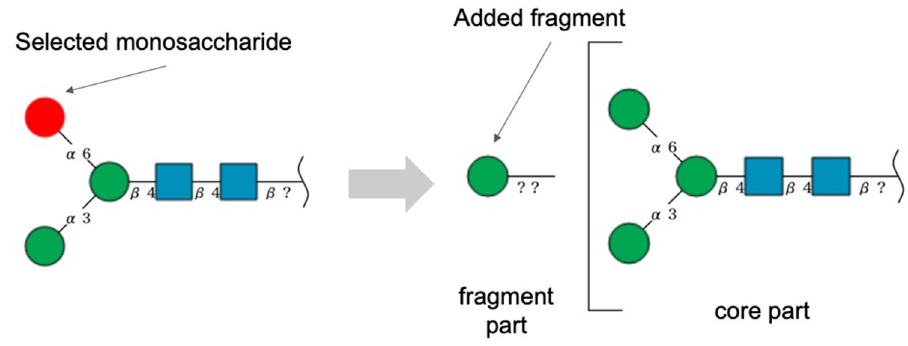
Figure 4. Addition of a monosaccharide as a fragment part using “Add Fragment”. To select possible attachment sites of the fragment part, users can use the pop-up window for editing monosaccharide structure information as described above. In the pop-up window, the possible attachment sites on the core part can be selected, as shown in Figure 5. To indicate the potential connection sites of the fragment part, a unique number assigned to each fragment part is shown on the linkage of the fragment part as well as the monosaccharides of the core part. These numbers are not shown when all possible sites on the core part are selected. These fragment glycans can also be imported and exported in GlycoCT and WURCS formats using “Import String” and “Export String”, respectively (Figure 6).